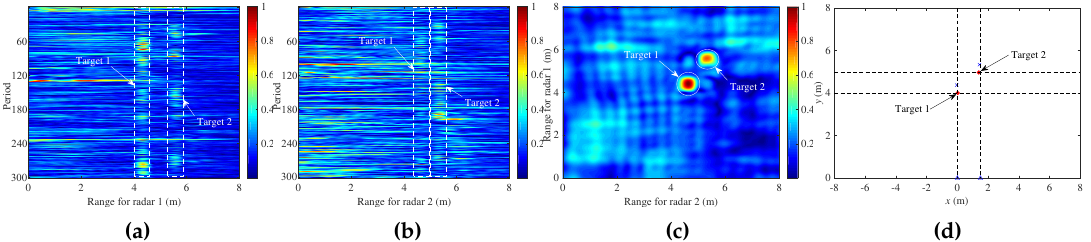
Figure 20. Results of Experiment 4.1: ( a ) range profile plane for Radar 1; ( b ) range profile plane for Radar 2; ( c ) cross-correlation image; and ( d ) localization result.